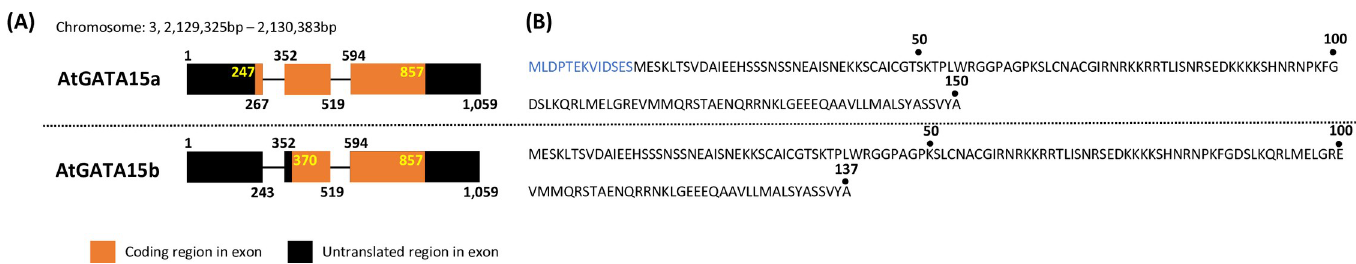
Fig 2. Gene structure and protein sequence of alternative splicing forms of AtGATA15 gene in A . thaliana Kn0. (A) shows gene structure of two alternative splicing forms of AtGATA15 gene in A . thaliana Kn0 genome. Black- or orange-colored boxes indicate untranslated and coding regions in exons, respectively. Black lines mean intron regions. Numbers around exon boxes present relative base pair position started from a transcript start position of the AtGATA15 gene. The chromosomal position of the AtGATA15 gene is displayed on the top of the diagram. (B) exhibits protein sequences of alternative splicing forms of the AtGATA15 gene. Black dots with numbers present the position of amino acids. The amino acids marked in blue letters indicate AtGATA15a specific amino acids.